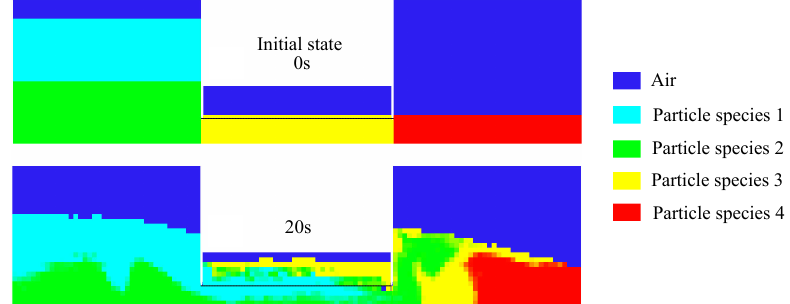
Figure 6. Particle distribution shown by the mixing of four differently coloured particle species.